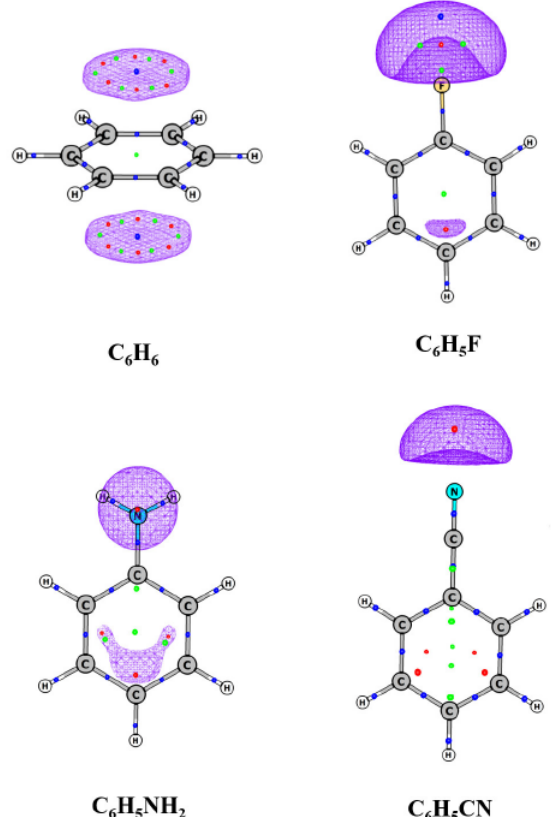
Figure 9. MESP isosurfaces of benzene and monosubstituted benzenes. The isosurface values are − 10, − 10, − 20, − 30 kcal/mol for C 6 H 6 , C 6 H 5 F, C 6 H 5 NH 2 and C 6 H 5 CN, respectively. B3LYP/6-311G (d, p) calculations. See text for